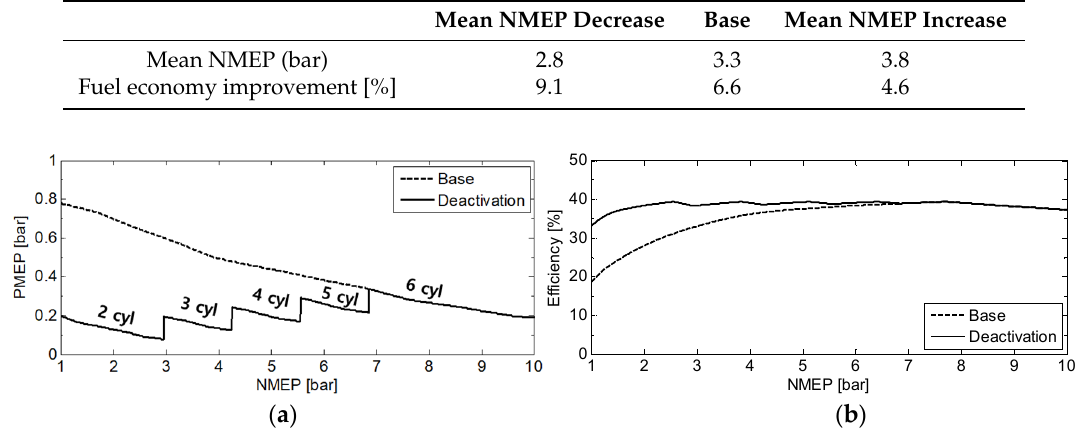
Figure 5. Comparison of results between base engine and cylinder deactivation engine; ( a ) PEMP; ( b ) engine efficiency.